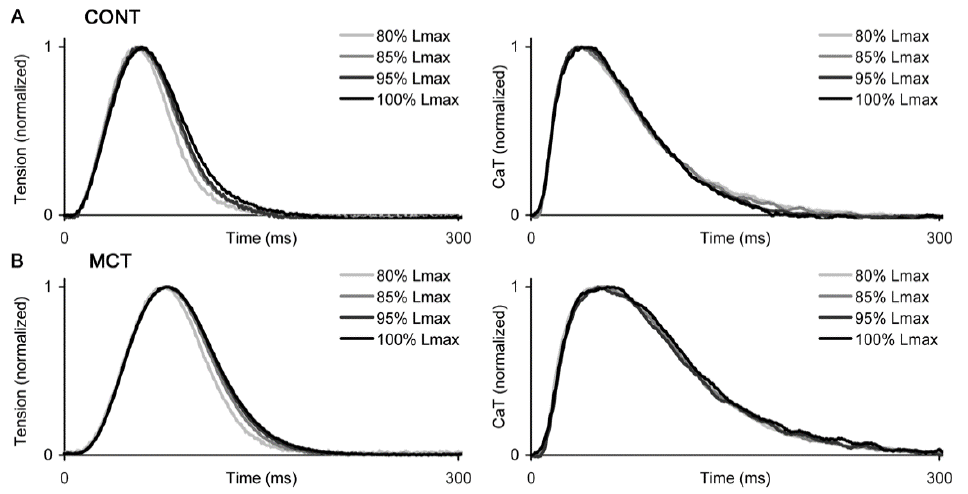
Figure 3. The representative self-normalized traces of isometric force (left panels) and Ca transients (CaT, right panels) measured in the right atrial strips under different preloads (within a force-length protocol, indicated as a % of L MAX ). ( A ) Atrial strips of control rats (CONT). ( B ) Atrial strips of monocrotaline-treated rats (MCT). Each individual trace is normalized to its peak. The measurements were done at 30 ◦ C and a 2 Hz pacing